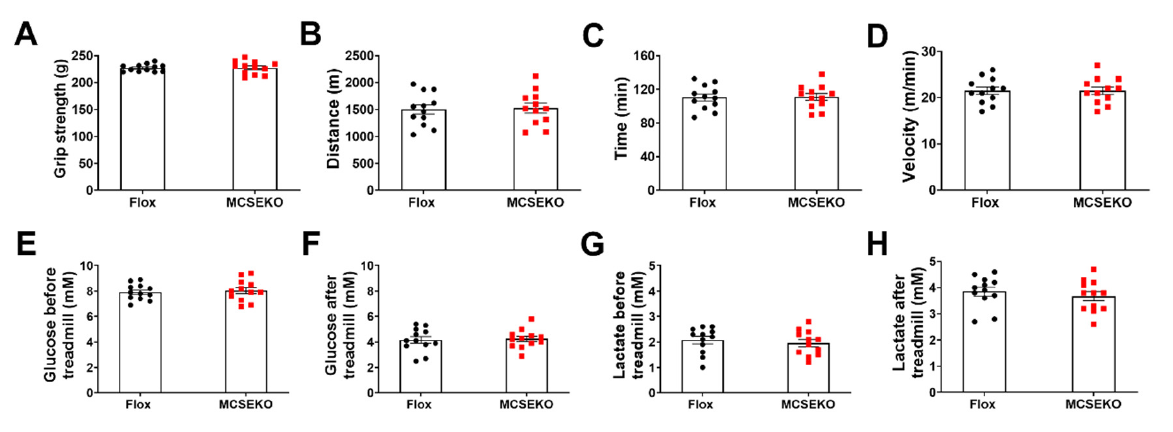
Figure 2. MCSEKO mice display normal grip strength and exercise capacity. The mice were housed under standard conditions. The grip strength and treadmill exhaustion exercise capacity were measured on Flox mice and the MCSEKO mice at 20 weeks old. ( A ) The grip strength of Flox mice and the MCSEKO mice ( n = 12 in each group). ( B – D ) The running distance, running time, and running maximum velocity of Flox mice and the MCSEKO mice ( n = 12 in each group). ( E , F ) The blood glucose level of Flox mice and the MCSEKO mice before and after running exhaustion ( n = 12 in each group). ( G , H ) The blood lactate level of Flox mice and the MCSEKO mice before and after running exhaustion ( n = 12 in each group). Data were expressed as means ± SEM.